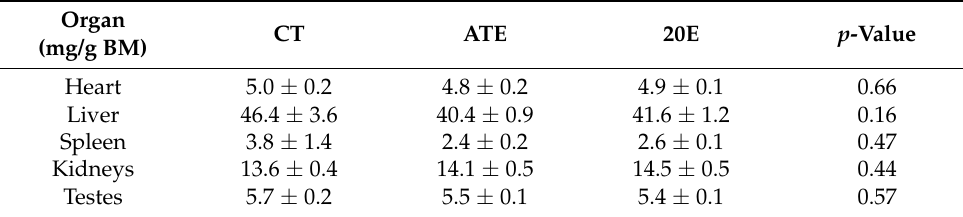
Table 3. Organ wet weight.